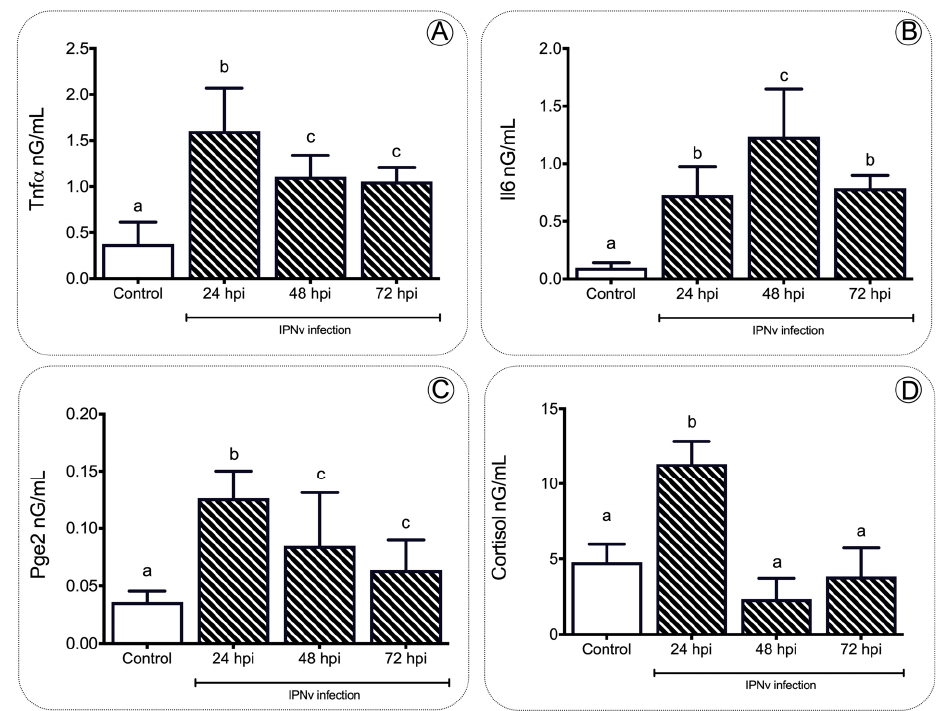
Figure 2. Expression profile of inflammatory mediators during infection. Plasmatic concentration of Tnfa ( A ), Il6 ( B ), Pge2 ( C ) and cortisol ( D ) in salmon after IPNv infection. Data represent the mean ± SEM. One-way ANOVA. p < 0.05 was considered statistically significant. Different letters denote significant differences.